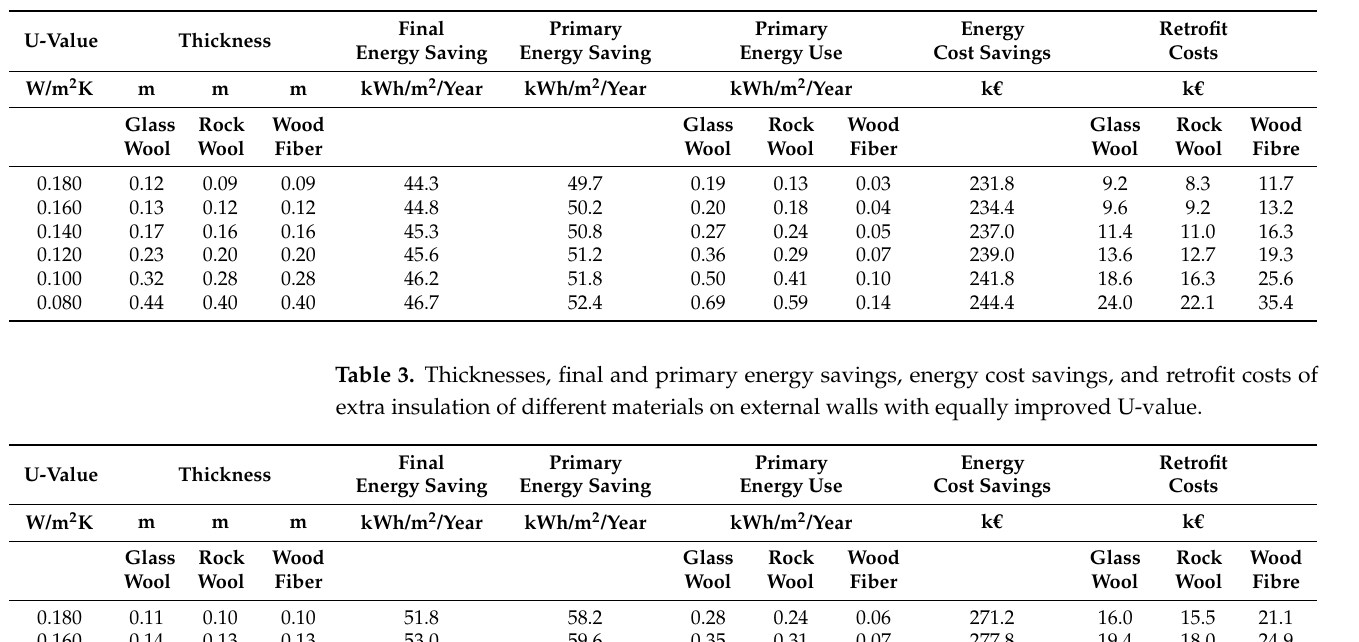
different materials. Table 5 shows different U-values of new windows. The respective final and primary energy savings, as well as the energy cost savings and retrofit costs of different material options, are also shown in the aforementioned tables. Both the energy cost savings and retrofit costs are calculated in terms of NPV based on the economic assumptions in the Reference scenario. The final and primary energy savings are calculated considering marginal changes in the DH supply systems due to different retrofit measures. The initial building (without retrofit options) shows a final energy use of 108 kWh/m 2 /year and primary energy use of 157 kWh/m 2 /year for space heating. Table 2. Thicknesses, final and primary energy savings, energy cost savings, and retrofit costs of extra insulation of different materials on the attic floor with equally improved U-value.